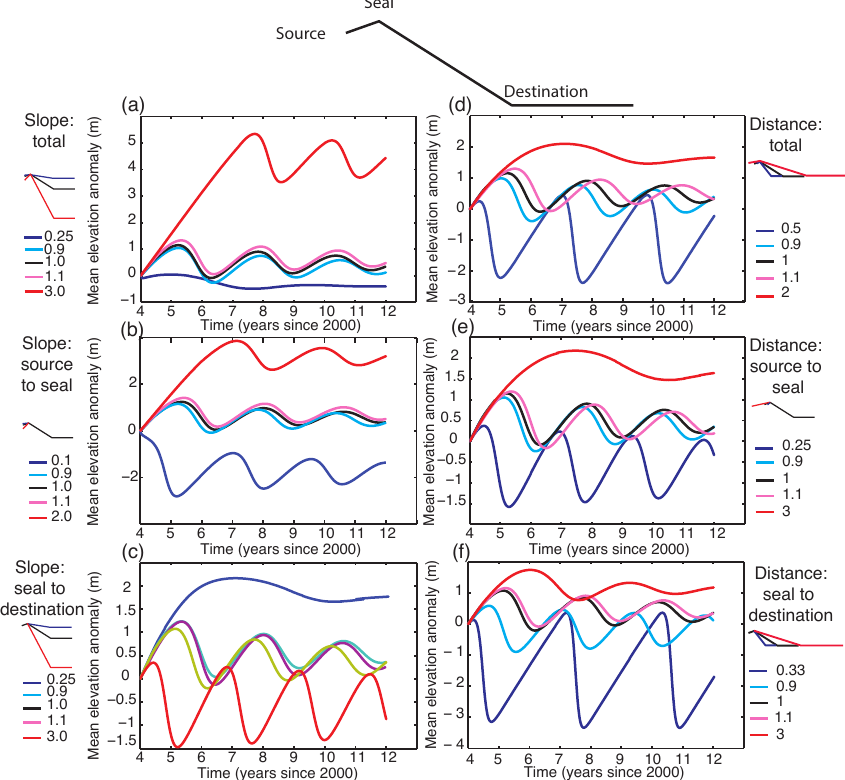
Figure 8. Sensitivity of canal model to flow path geometry in the idealized domain. Left panels (a, b, c) show sensitivity of model output to changes in vertical scaling: (a) vertical exaggeration applied to the entire domain; (b) vertical exaggeration applied upstream of seal; and (c) vertical exaggeration applied downstream of seal. Right panels (d, e, f) show sensitivity of model output to changes in horizontal scaling: (d) horizontal stretching applied to the entire domain; (e) horizontal stretching applied upstream of seal; and (f) horizontal stretching applied downstream of